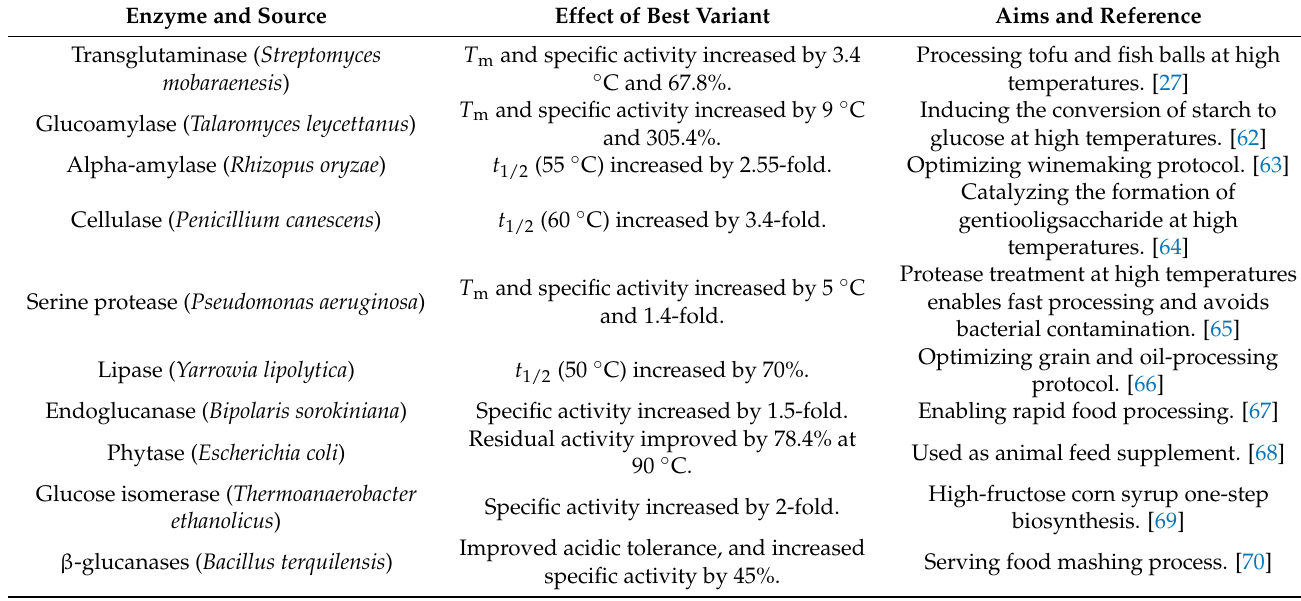
Table 2. Enzyme modification and the modification